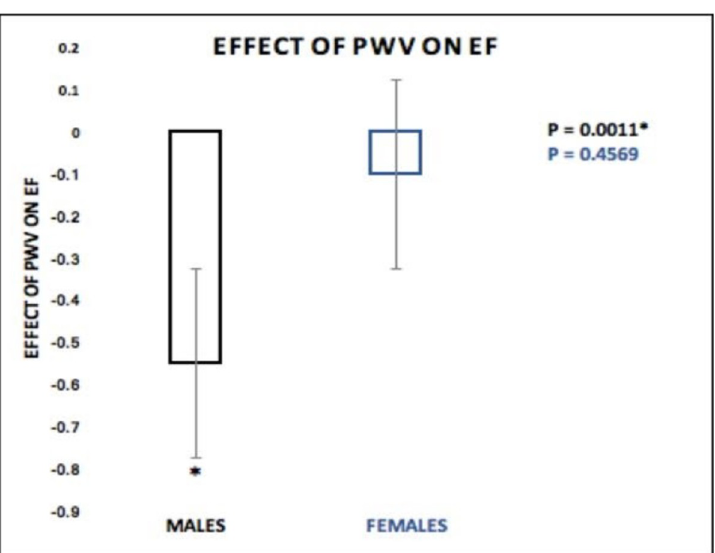
Fig 4. Effect of PWV on EF: The effect of PWV on EF was significantly negative in males (B = -0.5501, SE = 0.1563, 95% CI [-0.8656, -0.2346], p = 0.0011) but not significant in females (B = -0.1022, SE = 0.1361, 95% CI [-0.3769, 0.1725], p = 0.4569).